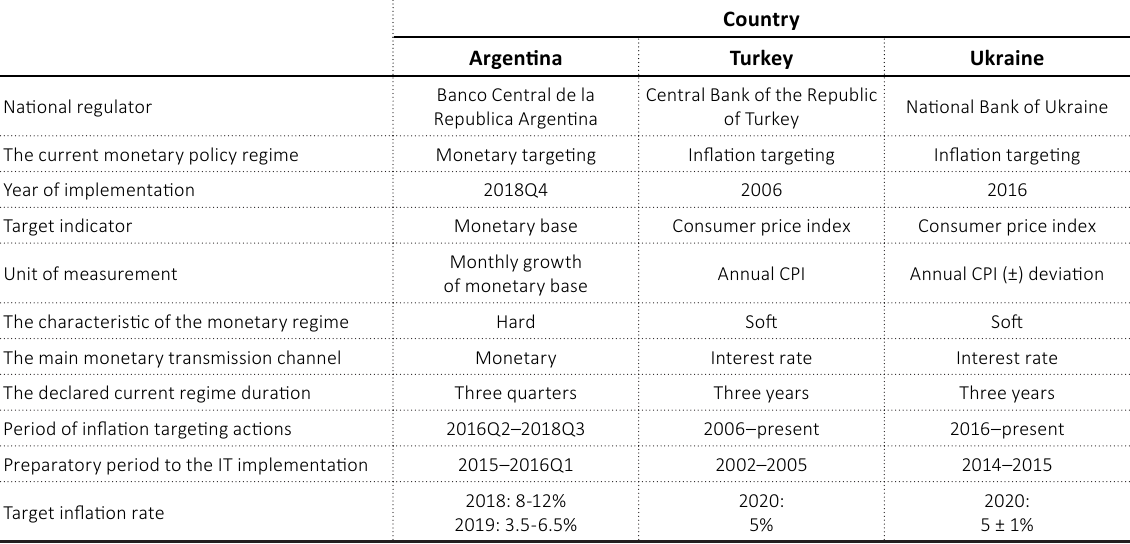
Table 1. National features of the structure of monetary policy in Argentina, Turkey, and Ukraine Source: Based on data from the official websites of the central banks of Argentina, Turkey, and